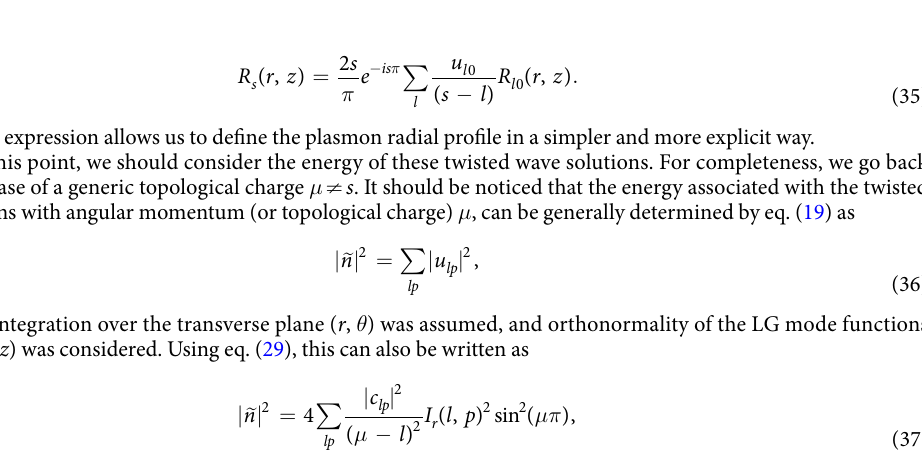
Figure 2. Approximate value of the total energy associated (a.u.), for an arbitrary value of the topological charge μ , varying in the interval ( − 1, 1). The energy shows two minima, at μ ≡ s = ± 1/2. When we reduce the energy of the LG mode l = 0, from μ = − 1 to 1, these energy minima disappear, as shown in the dashed curve (for μ =